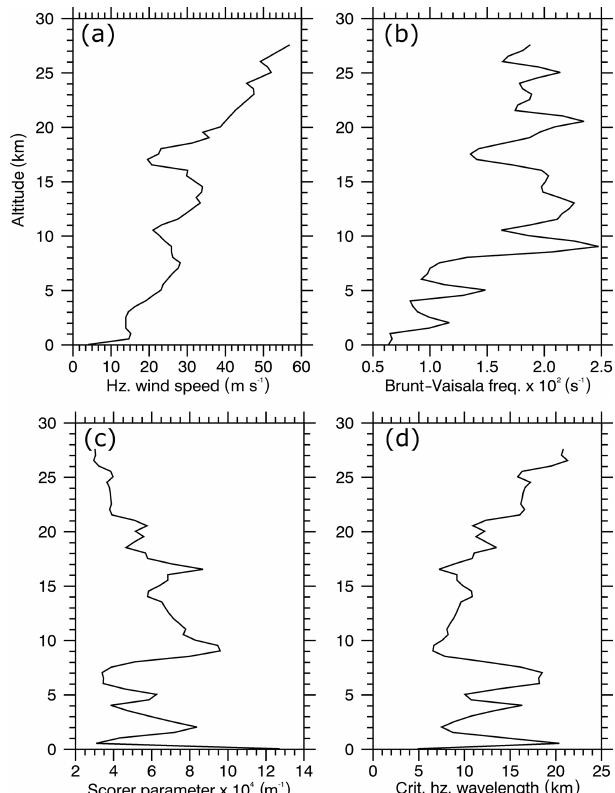
Figure 5. Vertical profiles of (a) horizontal wind speed, (b) Brunt– Väisälä frequency, (c) Scorer parameter and (d) critical horizontal wavelength of the radiosonde launched at Stavanger (St) in southern Norway (Fig. 1) at 12:00UTC on 28